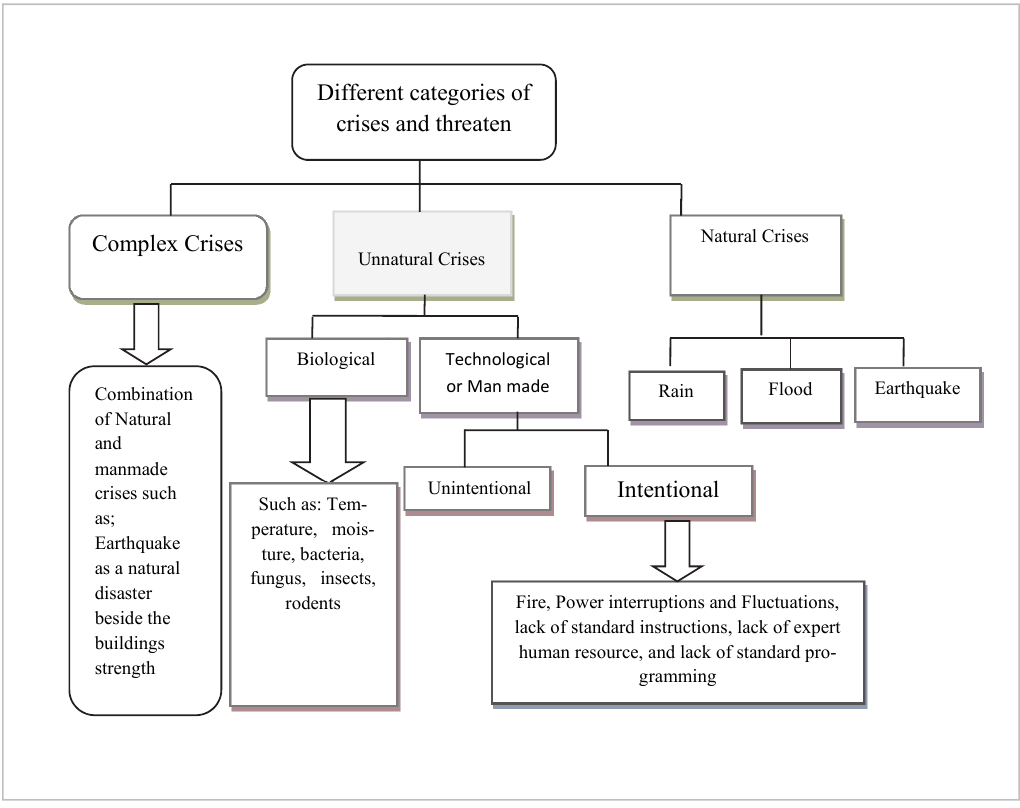
Fig. 1. Classification of Types of and Threats and Crisis in the National Archives of